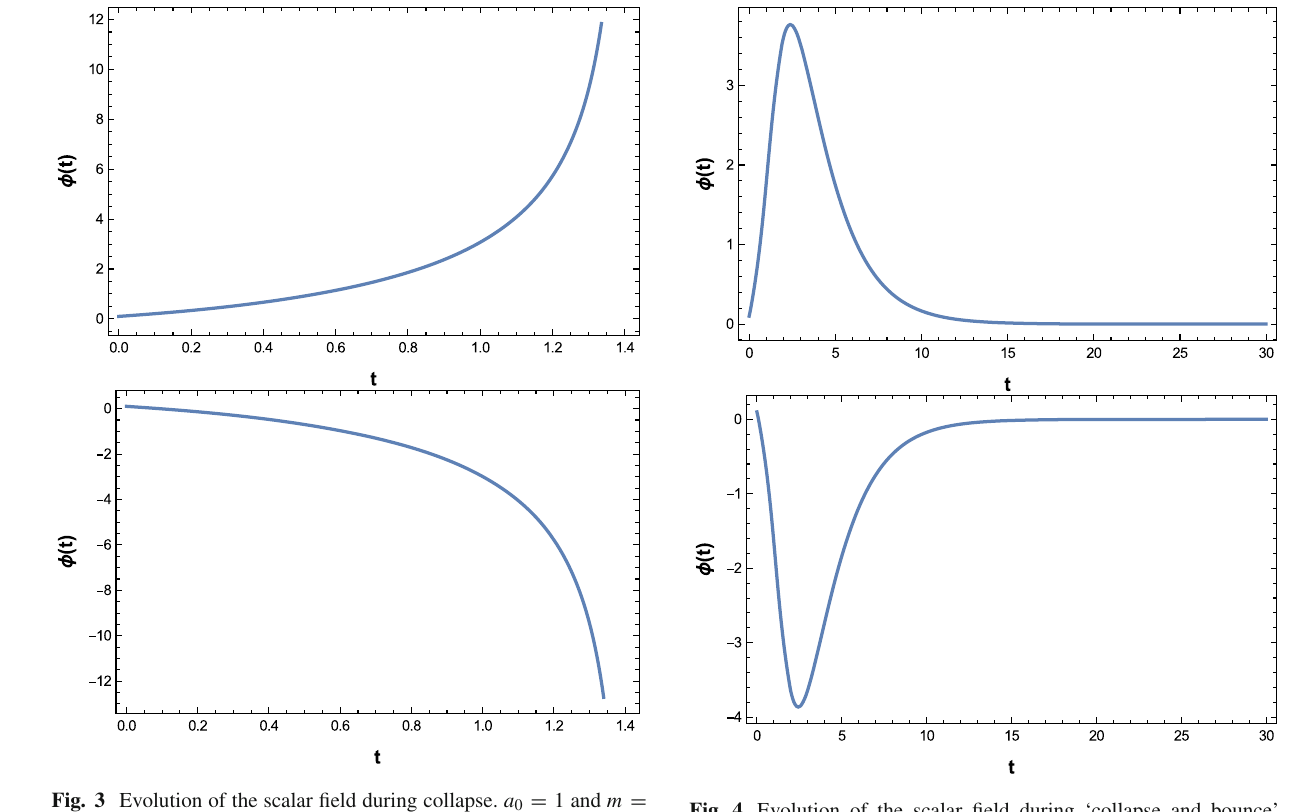
Fig. 4 Evolution of the scalar field during ‘collapse and bounce’. a 0 = − 1 and m = 1 √ . The initial conditions chosen for the numerical 2 for an initial time t i . The graph solutions are the values of a ( t ) and da ( t ) dt > 0 and the graph on bottom are for on top is for initial condition da ( t ) dt t = ti < initial condition da ( t ) dt t = ti